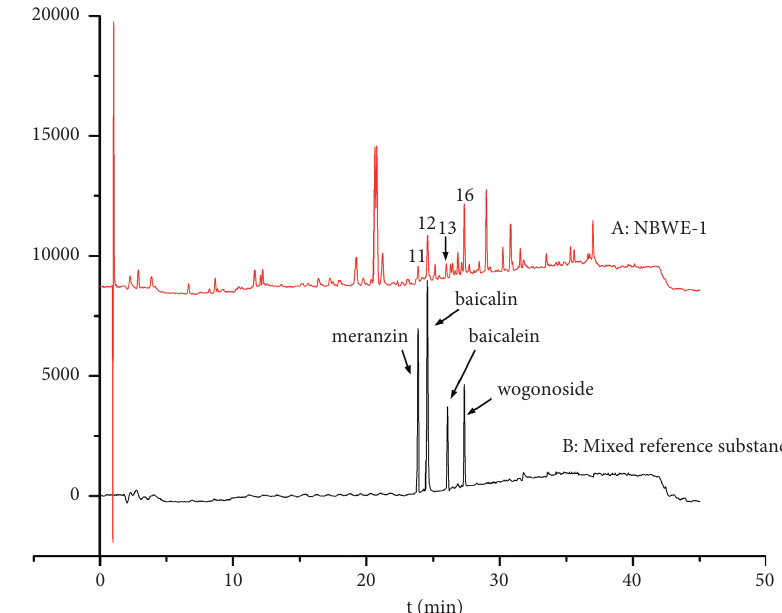
Figure 7: Comparison of chromatograms of Qing Jin Hua Tan Tang extracts and reference